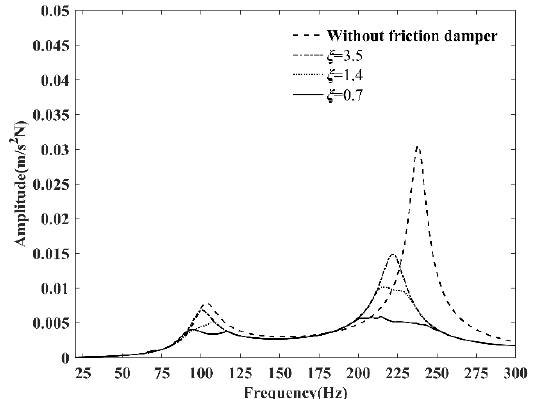
Figure 14. Theoretical AFRF of thrust bearing with friction damper for various values of 𝜉 .